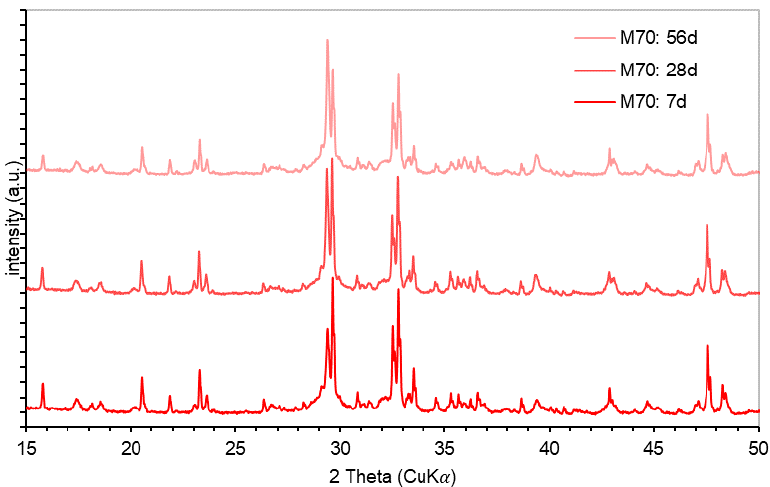
Figure 10. XRD patterns of alkali-activated slag at 70 °C and different curing times.